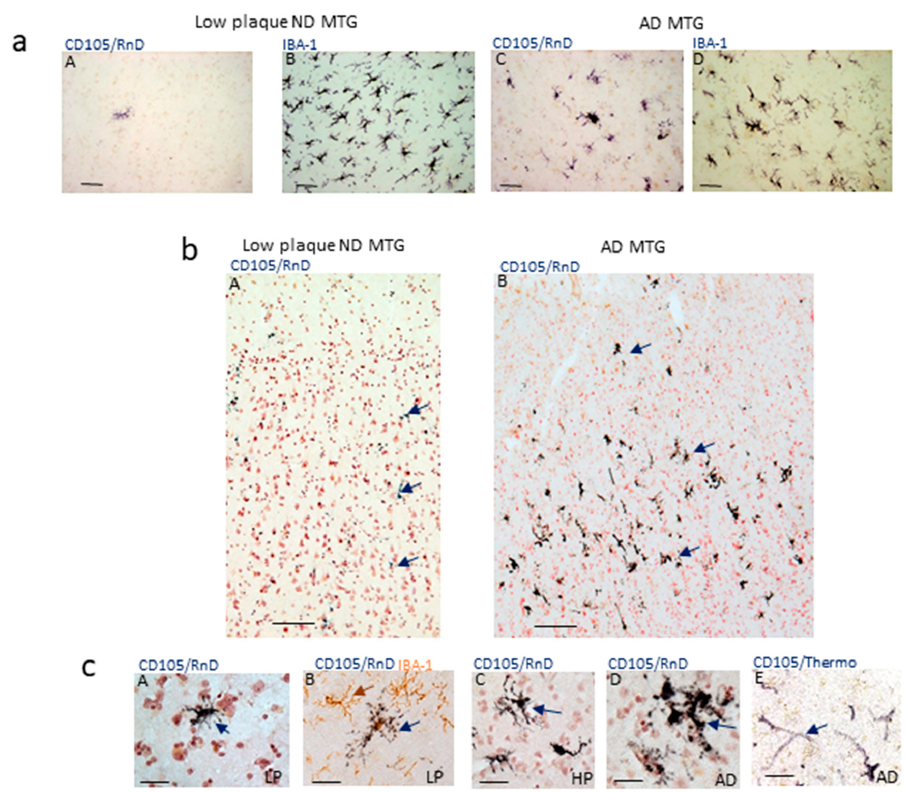
Figure 1. Patterns of Staining of CD105/MAB1097 in human brain sections. ( a ) Staining of parallel sections of MTG from a low-plaque ND case for CD105/MAB1097 (panel A) (CD105/RnD) and IBA-1 (panel B). Staining of parallel sections of MTG from an AD case for CD105/RnD (panel C) or IBA-1 (panel D) . All images have the same magnification. Scale bars represent 50 μ m. ( b ) Low magnification images showing distribution of CD105-positive cells in low-plaque ND (panel A) and AD cases (panel B). Representative positive cells indicated by purple arrows. Both images at same magnification. Scale bars represent 100 μ m. ( c ) Representative image of CD105 positive cells in low-plaque ND (LP) (panel A) (purple arrow) Morphology of CD105-positive microglia compared to IBA-1-positive surrounding cells (brown arrow) in LP case (panel B). Images of CD105-positive microglia with activated morphology in HP (panel C) and AD cases (panel D) (purple arrows). (panel E) Vascular staining in AD case (purple arrow) using CD105/Thermo Fisher antibody. All images at same magnification. Scale bars represent 50 μ m.